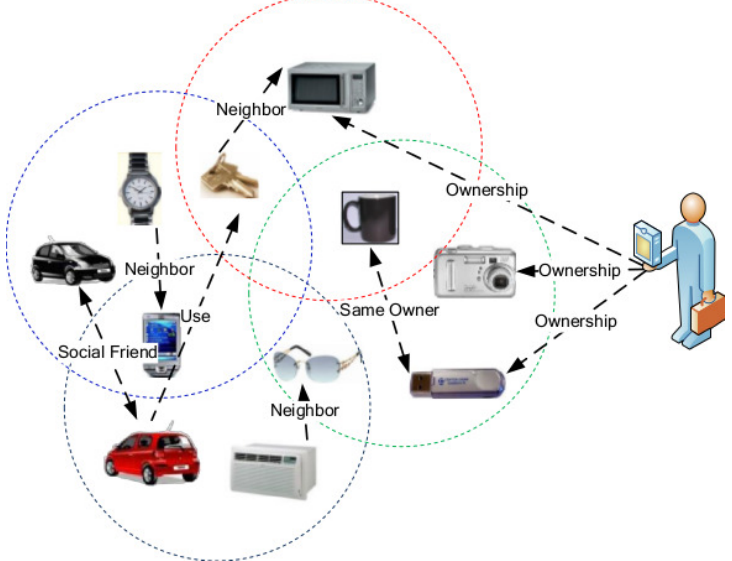
Figure 1. An example of a cyber-physical integrated